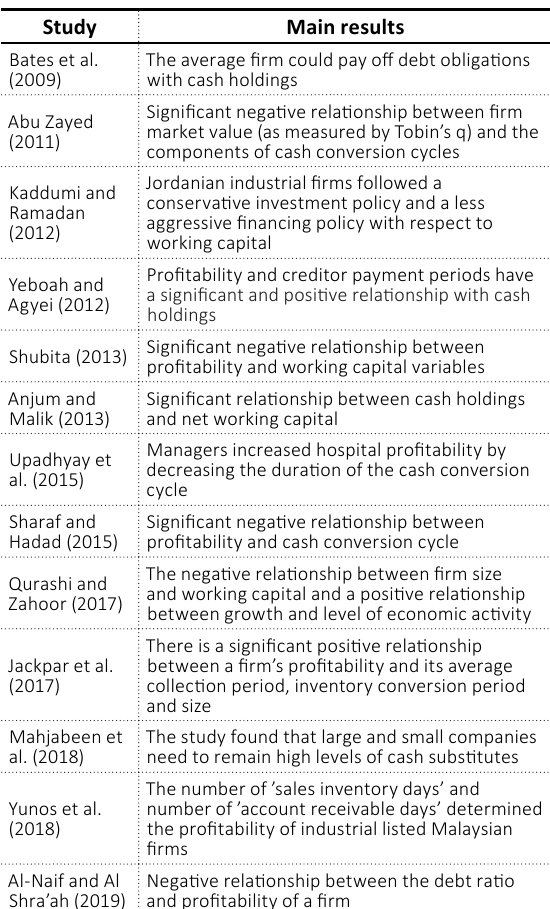
Table 1. Main results of previous